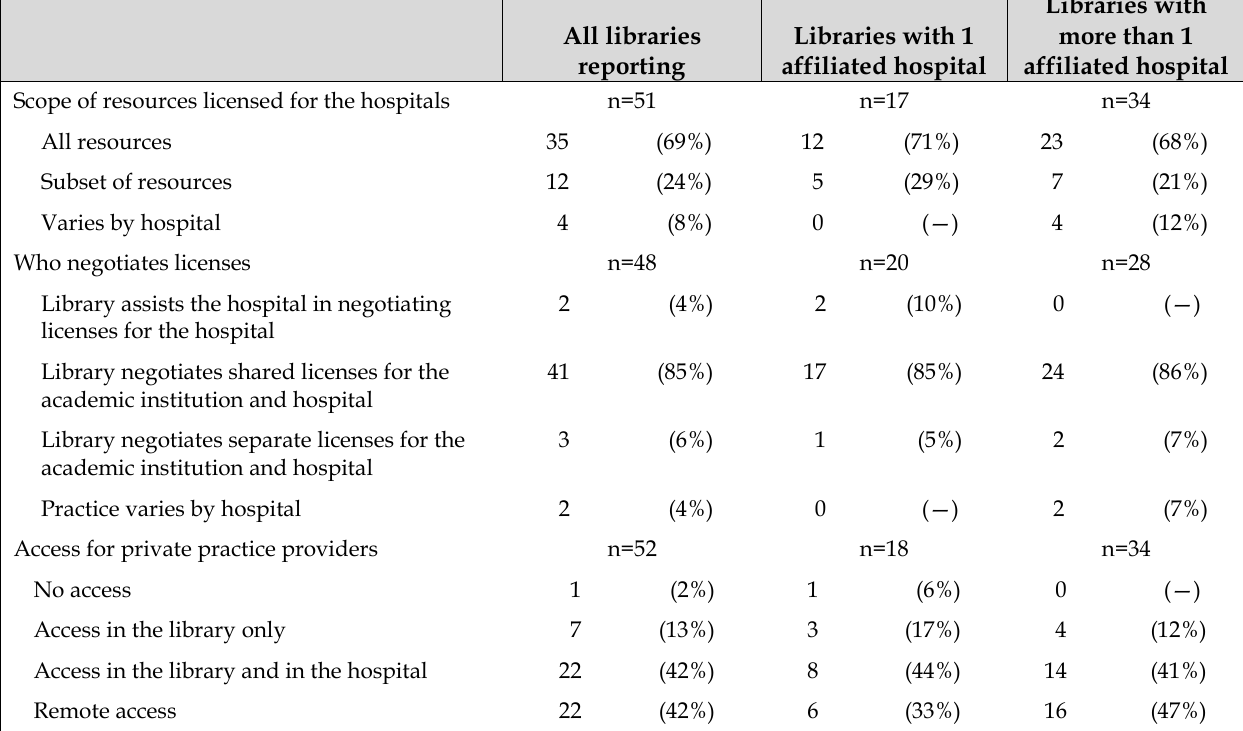
Table 1 Summary of responses on scope of resources licensed, who negotiates licenses, and access provided